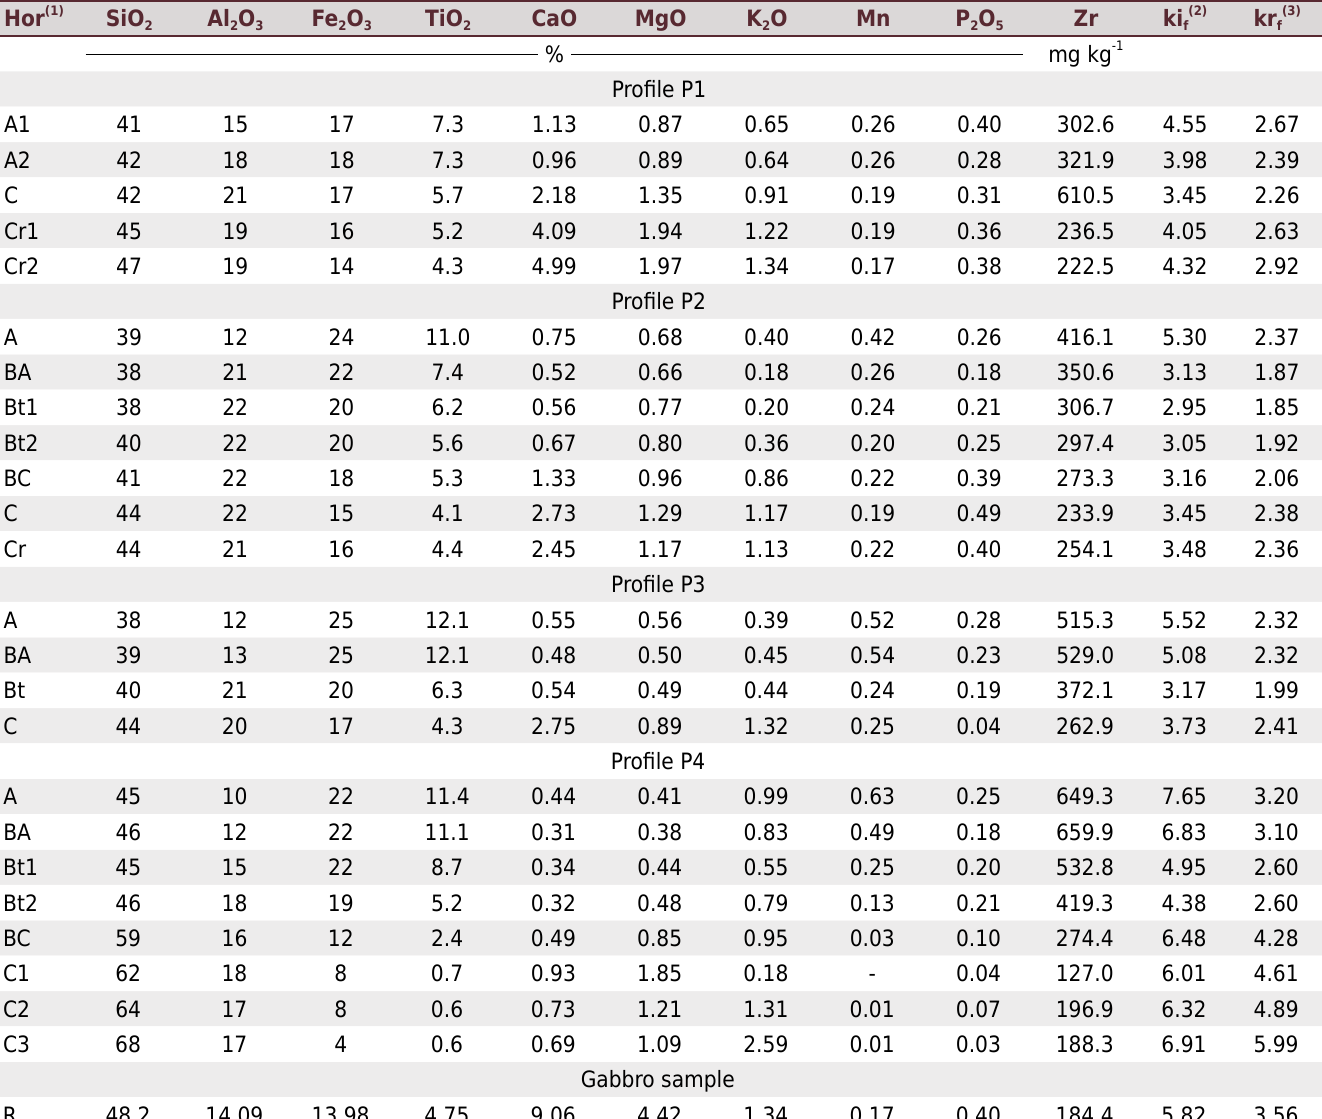
Table 4. Elements expressed as oxides, detected by X ray fluorescence (f), and molecular relationships ki f and kr f of soils in a toposequence in Pinheiral,